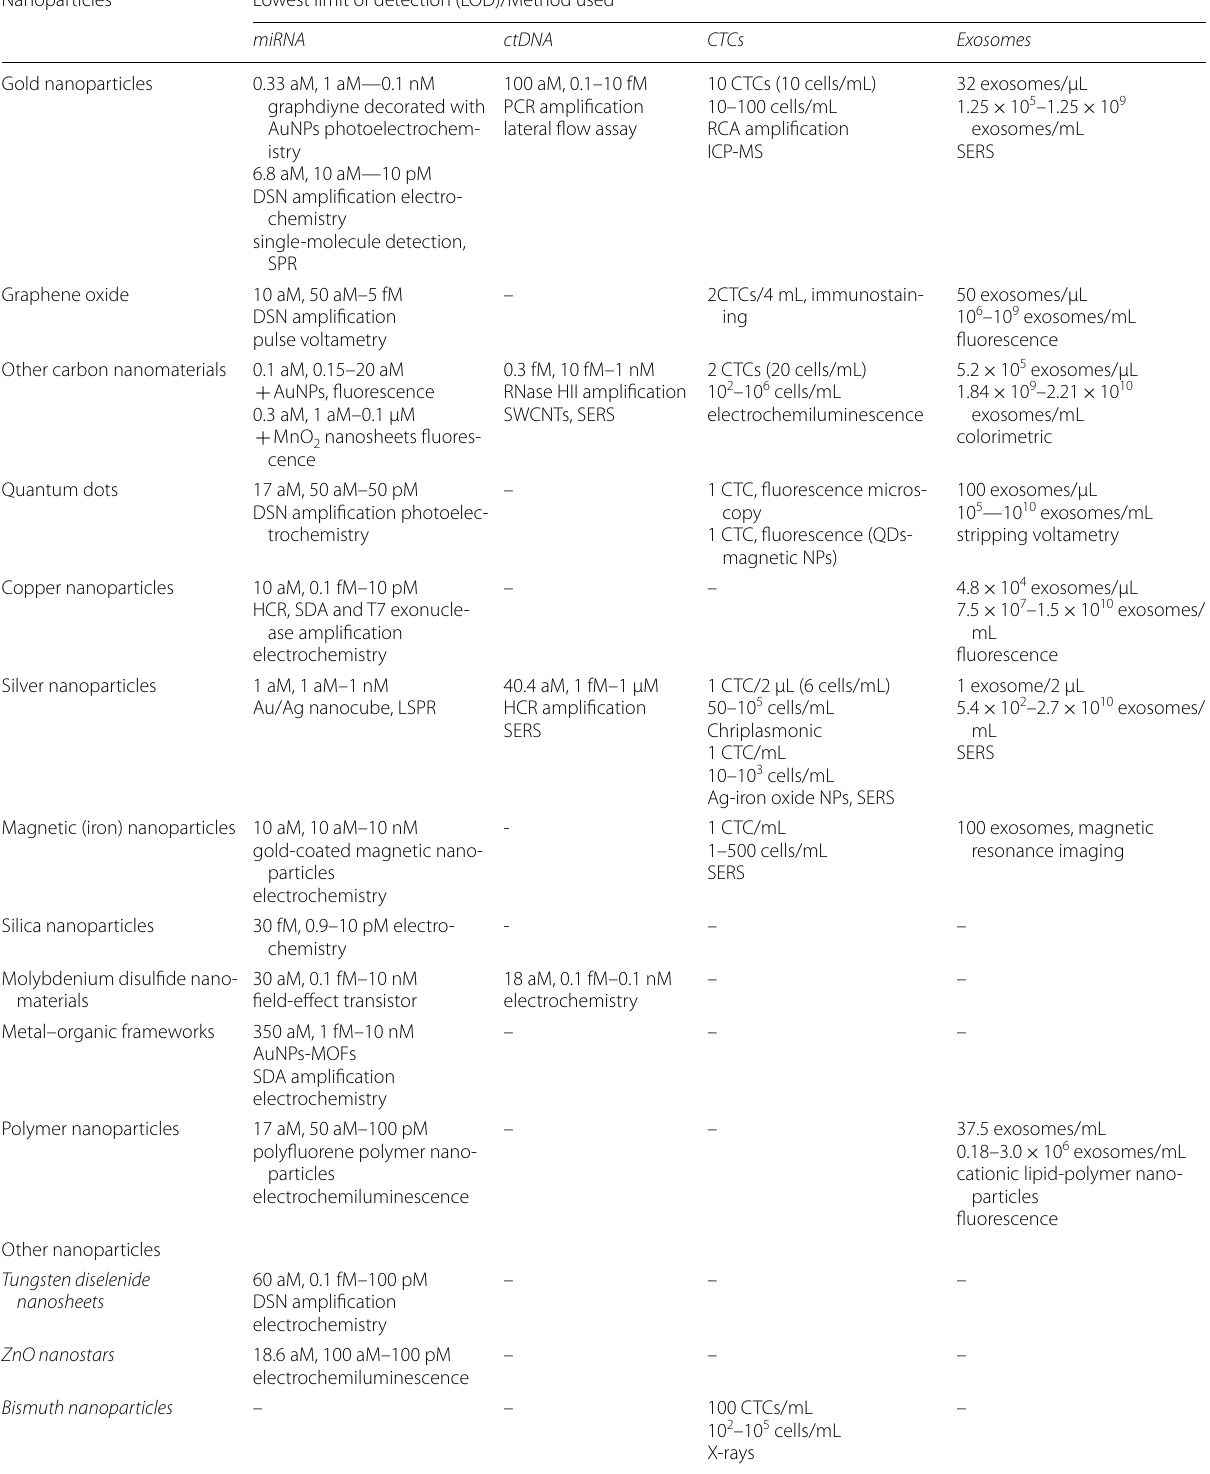
Table 1 Overview of the methods with the best analytical performance for the detection of miRNA, ctDNA, CTCs and exosomes using various nanoparticles/nanomaterials